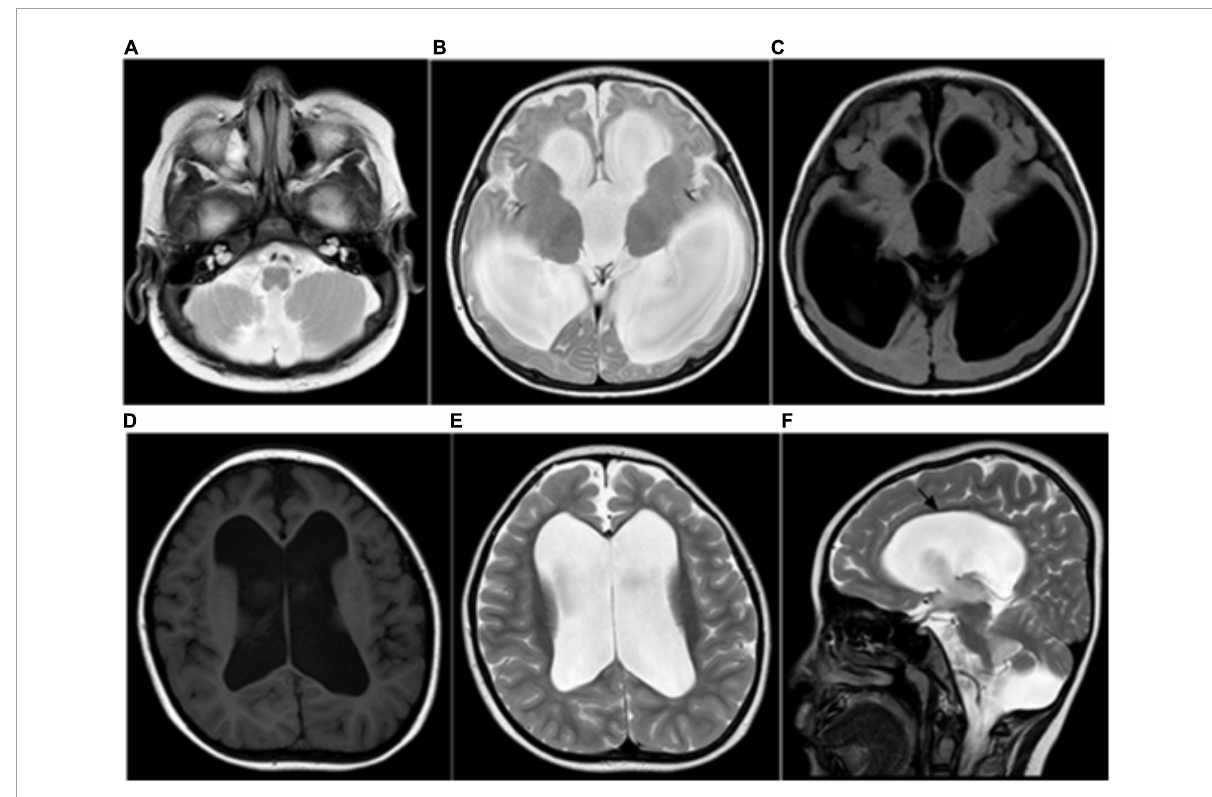
FIGURE1 (A–C) Ventricular dilation and a small cerebellar vermis, consistent with the Dandy–Walker variant. (D–F) MRI showing severe ventricular dilation and corpus callosal thinning (black arrow, sagittal